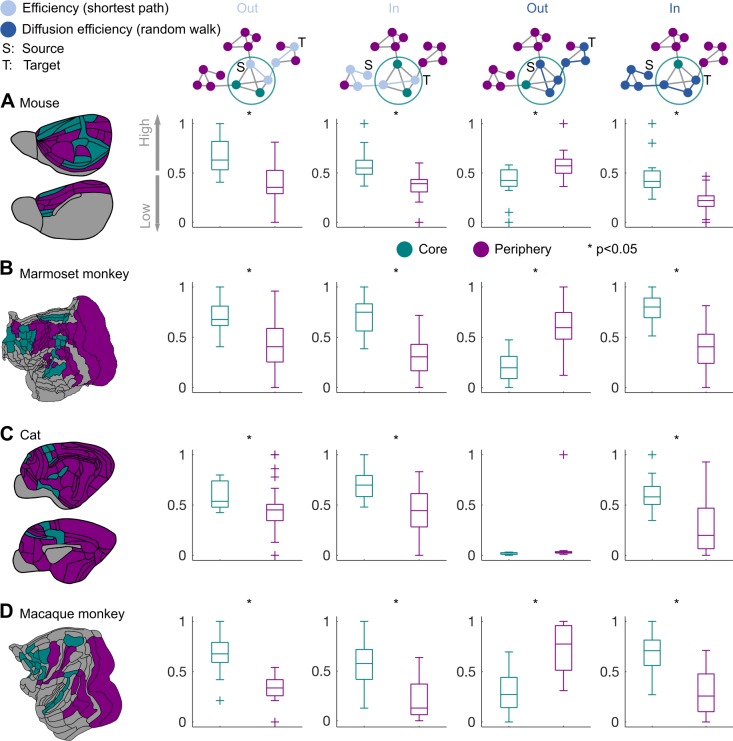
Core–periphery topology and network efficiency.Core areas of the (A) mouse, (B) marmoset monkey, (C) cat, and (D) macaque monkey connectome exhibit higher incoming efficiency than the periphery areas. Higher incoming efficiency is observed for the core under two different modes of network communication—that is, when a shortest path (efficiency) or random walk (diffusion efficiency) mode of communication is assumed. Thus, under both modes of network communication, core areas can be reached faster than the periphery areas. The core areas also exhibit higher outgoing efficiency for the shortest path, but not for the random walk, mode of communication. Thus, for fast communication with other cortical areas, the structural core must adhere to a mode of communication that is geared toward shortest paths. Boxplot edges, lines, and whiskers and crosses depict the 25th and 75th percentiles, median, and extreme nonoutlier and outlier values, respectively. Differences of the distribution of efficiency values for the core and periphery areas were assessed with the Kolmogorov-Smirnov test, and statistical significance was assessed with permutation tests. Note that for visualization purposes, efficiency values were linearly rescaled to the 0–1 interval.